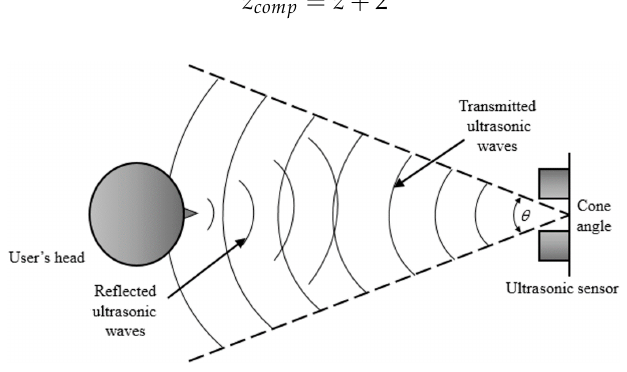
Figure 3. The measurement of z- distance with an ultrasonic sensor.